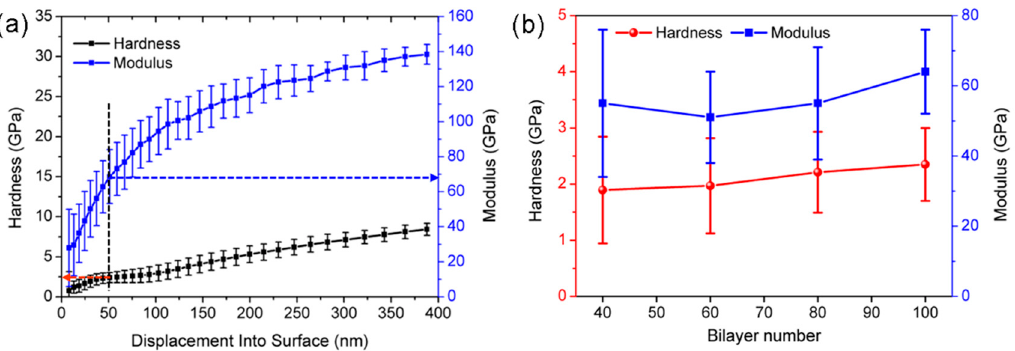
Figure 6. ( a ) Nano-indentation tests of the assembled 100 − bilayer film; ( b ) variation in the hardness and modulus with thickness.